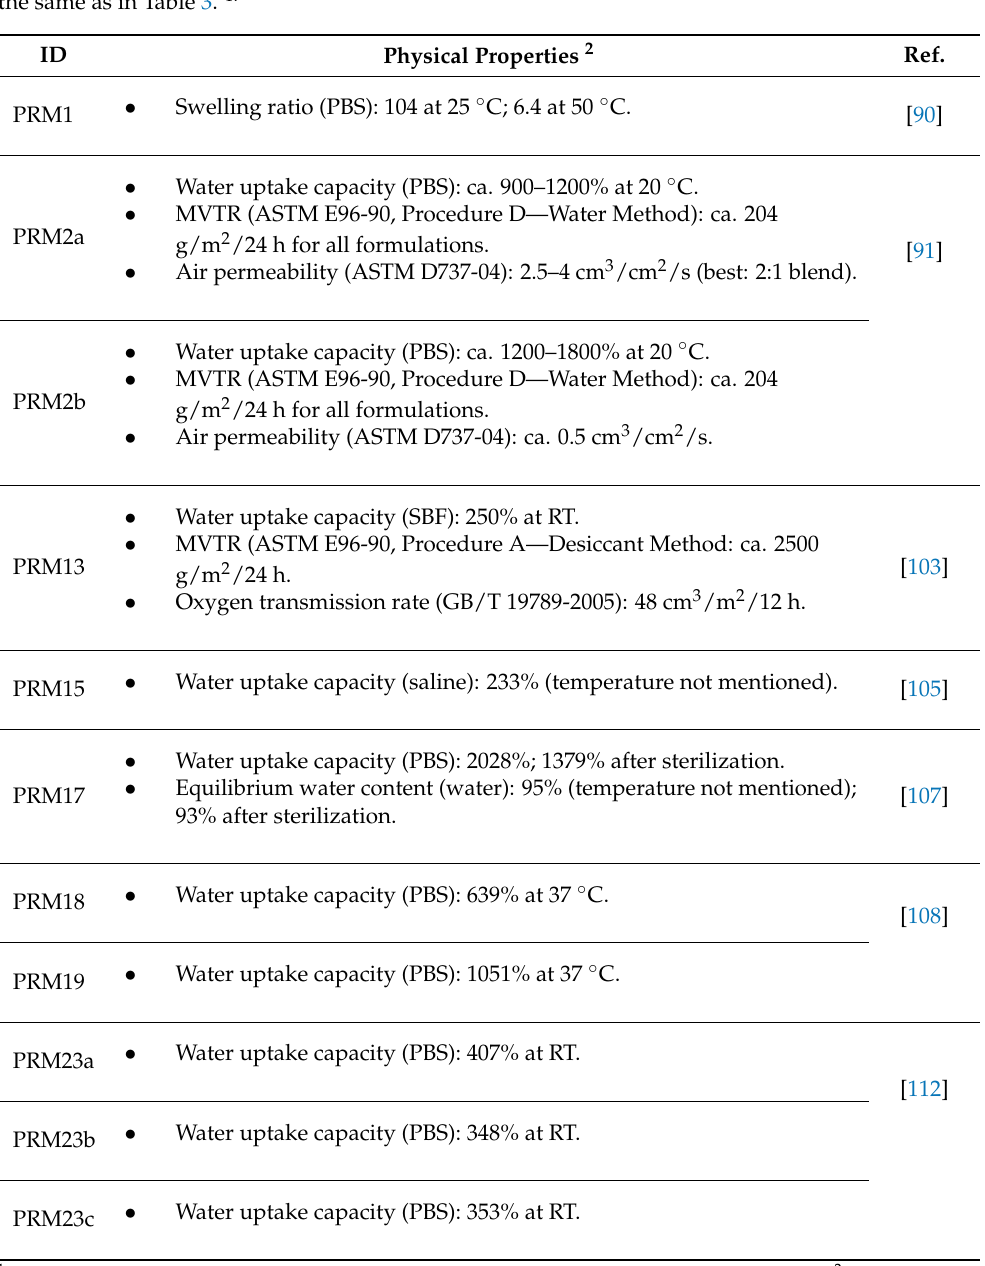
Table 6. Summary of the physical characterization of PHMB-releasing membranes (PRMs) developed for antimicrobial dressings (AMDs). Membrane IDs and corresponding bibliographic references are the same as in Table 3.